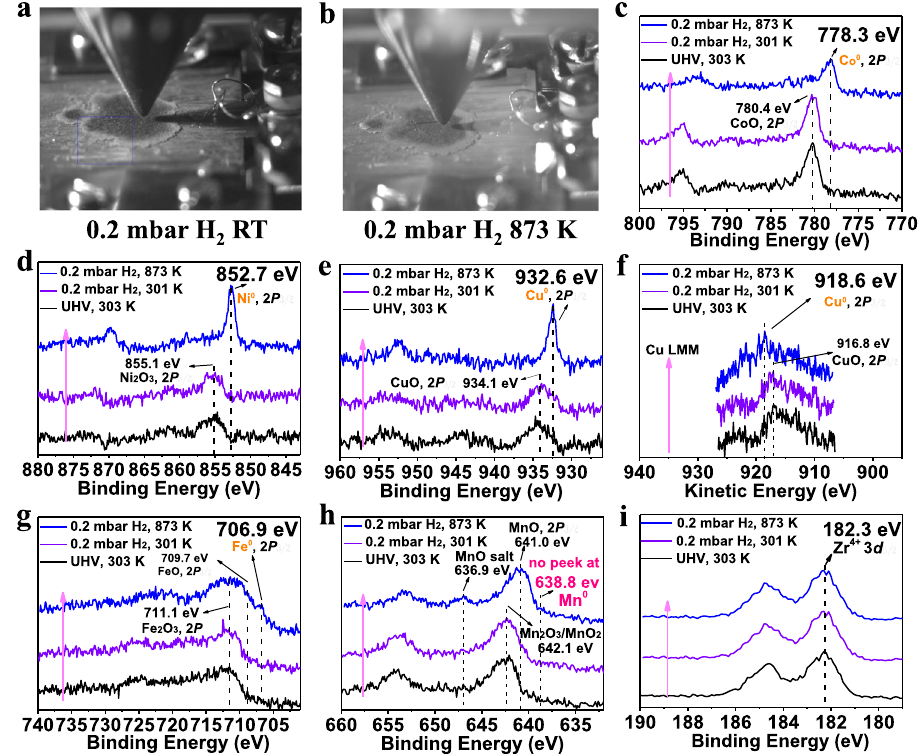
Fig. 7 In situ XPS measurements of Zr 0.5 (NiFeCuMnCo) 0.5 O x . The sample was treated with X-ray exposure under UHV (traditionally ultrahigh